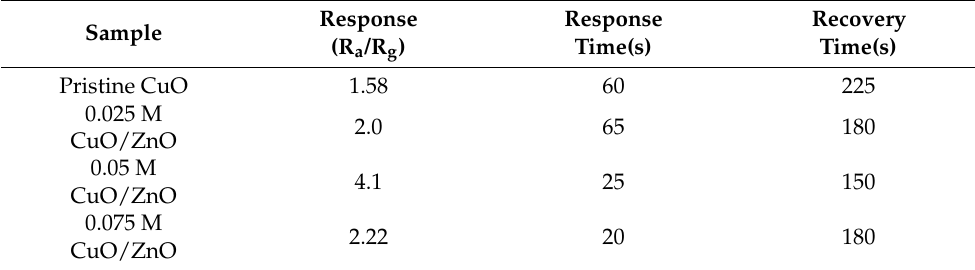
Table 2. Response, response time, and recovery time of CuO-based gas sensors (with different sol- gel concentration) to 100 ppm NO 2 gas at 250 °C.